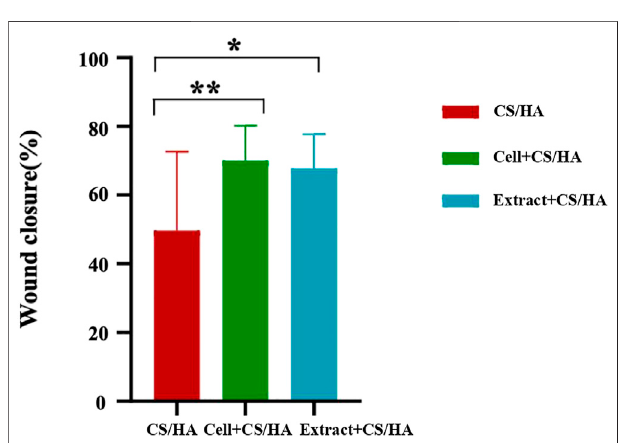
FIGURE2| ComparisonofwoundsizereductionamongCS/HA,extract + CS/HA, and cell + CS/HA treatments at 14 days post-wounding. Wound size reduction was signi fi cantly greater in extract + CS/HA and cell + CS/HA. Signi fi cant difference compared to CS/HA. * p < 0.05, ** p < 0.01. n (cid:1) 14 per